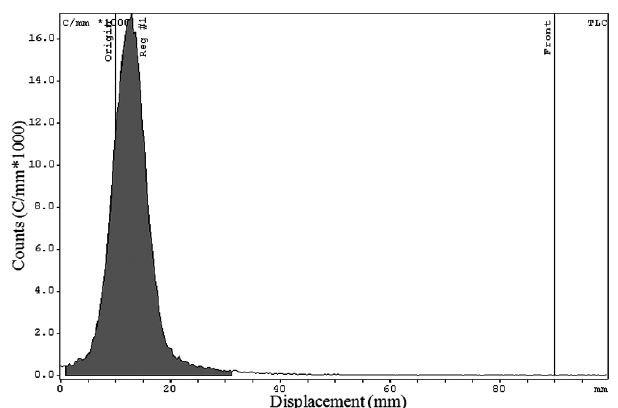
O mobile phase: 2